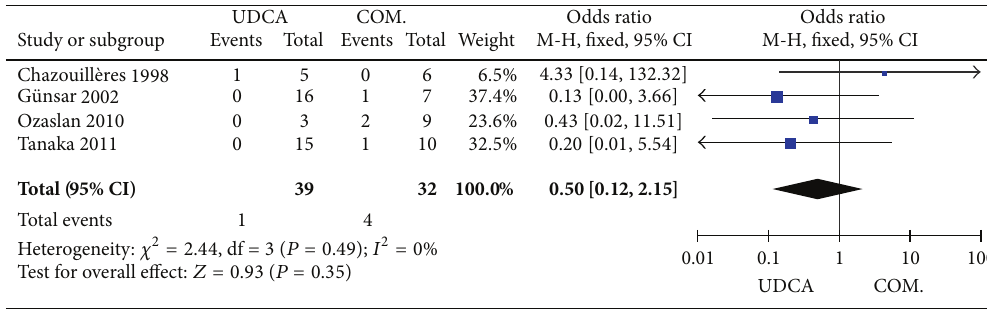
Figure 6: Death in patients treated with monotherapy versus combination therapy for PBC-AIH.